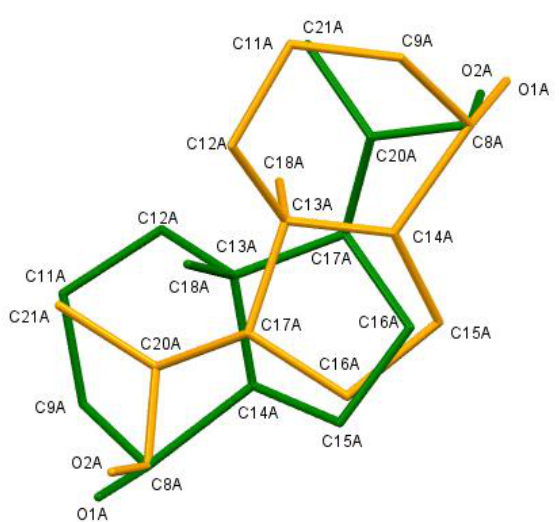
Figure 3. Disorder part of structure 3 . Atoms marked as green and orange have occupancy equal to 0.5. Atom C8A has occupancy equal to 1 and is present in both the green and orange molecules. The hydrogen atoms were omitted for clarity.